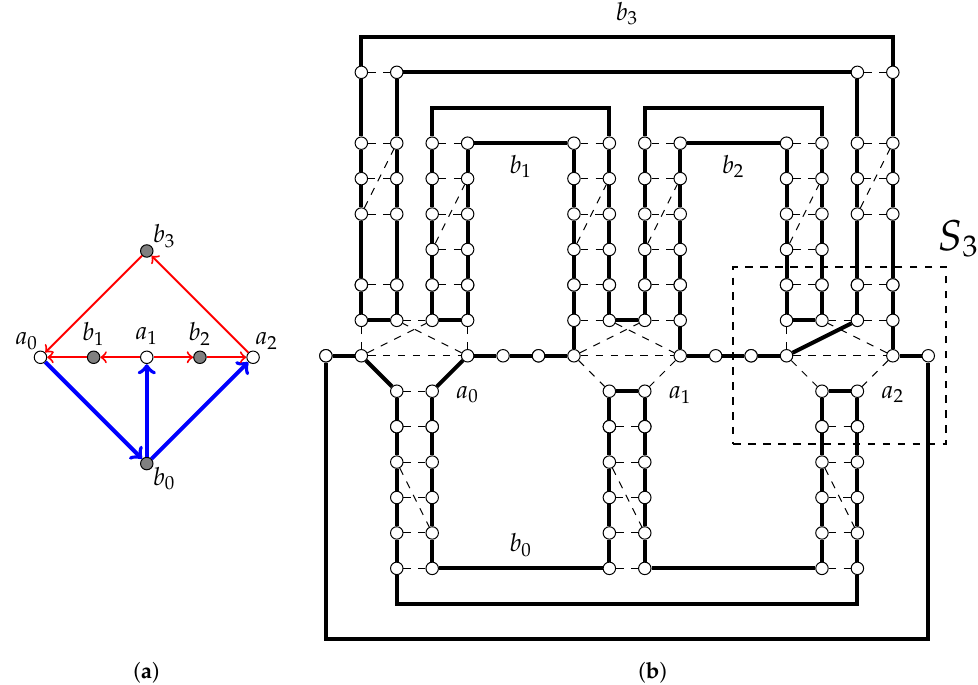
Figure 5. ( a ) a legal orientation of the problem Π . White points denote the vertices of A , and gray points denote the vertices of B . Thick (blue) lines denote the edges with weight 2, and thin (red) lines denote the edges with weight 1; ( b ) the Hamiltonian cycle obtained from the legal orientation in Figure 5a. We take the configuration S 3 for the gadget for a 2 , since the edges of a 2 are oriented as f 3